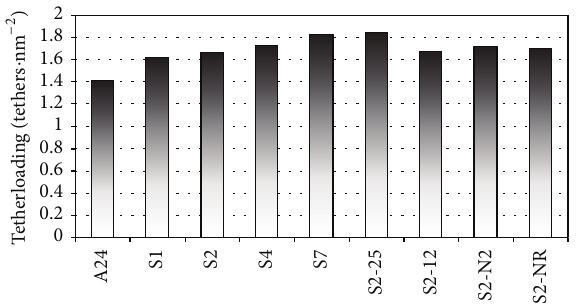
Figure 4: Tether loading calculated for of aminopropyl-functional- ized